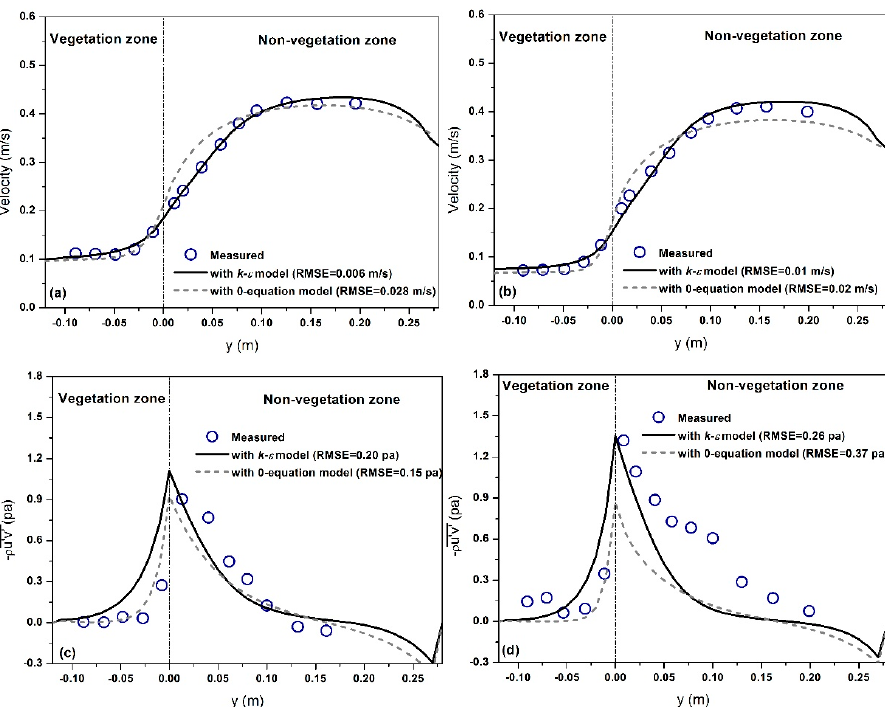
Figure 3. Comparison of experimental and computed profiles: ( a ) depth-averaged velocity for run-1; ( b ) depth-averaged velocity for run-2; ( c ) Reynolds stress for run-1; (d) Reynolds stress for run-2.